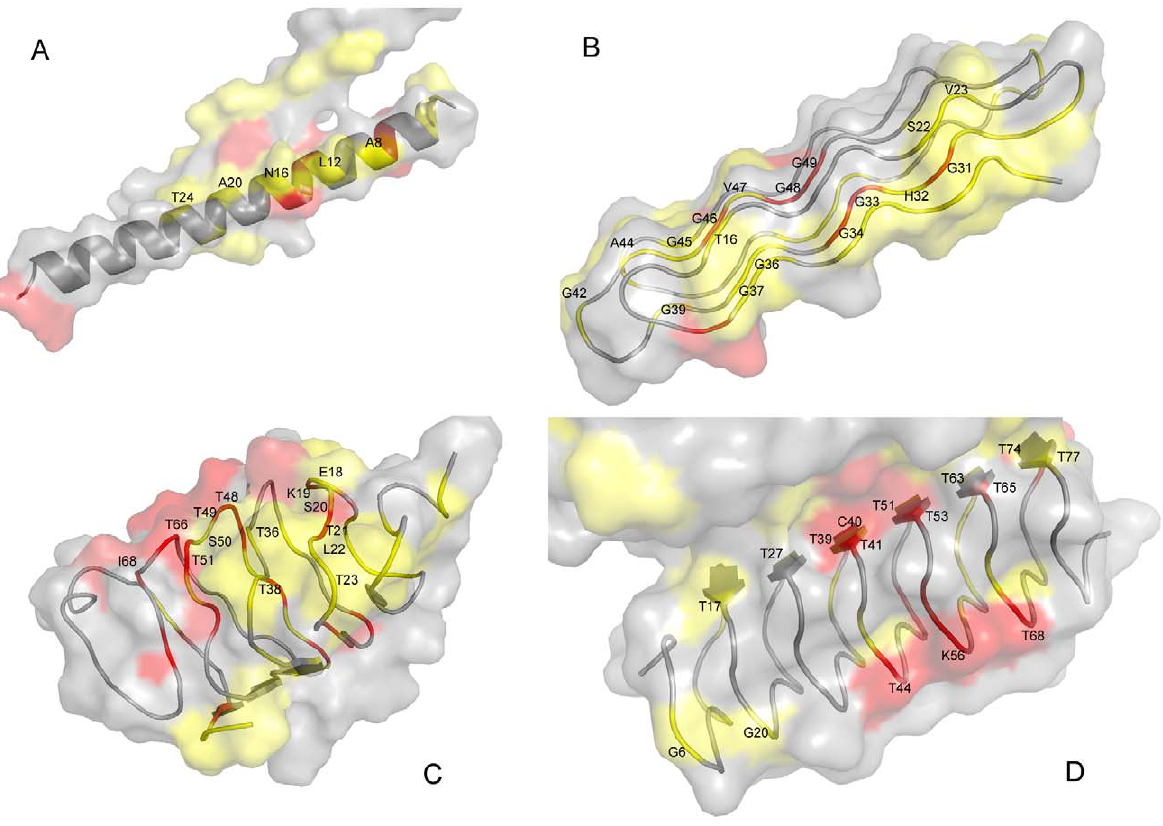
Figure 2. Examples of key residues mapped onto the surfaces of the seven representative AFPs used in the cross-validation tests. The structures were drawn using PyMOL [37]. Identification key residues are denoted in red (more votes) and yellow (fewer votes) for the following PDB structures: (A) the winter flounder a -helical AFP (PDB ID 1wfa) [35]; (B) the snow flea AFP (PDB ID 2pne) [38]; (C) the b -helical spruce budworm AFP (PDB ID 1eww) [13]; (D) the b -helical beetle Tenebrio molitor AFP (PDB ID 1ezg)